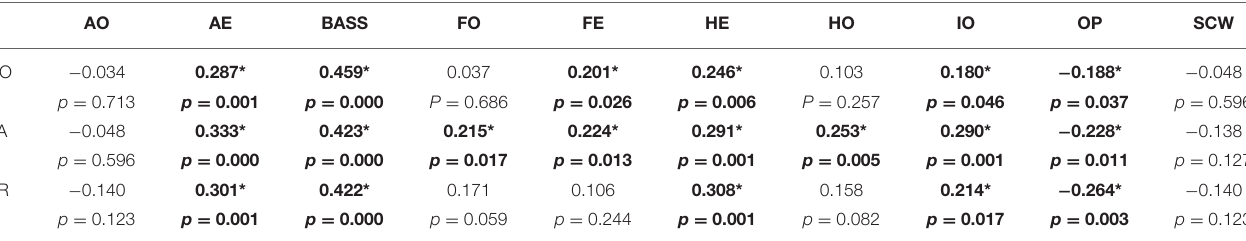
TABLE 2 | Results of the correlation analysis (Spearman’s rho) for women with DRAM in the 1–12 months postpartum period ( N = 123). AO AE BASS FO FE HE HO IO OP SCW